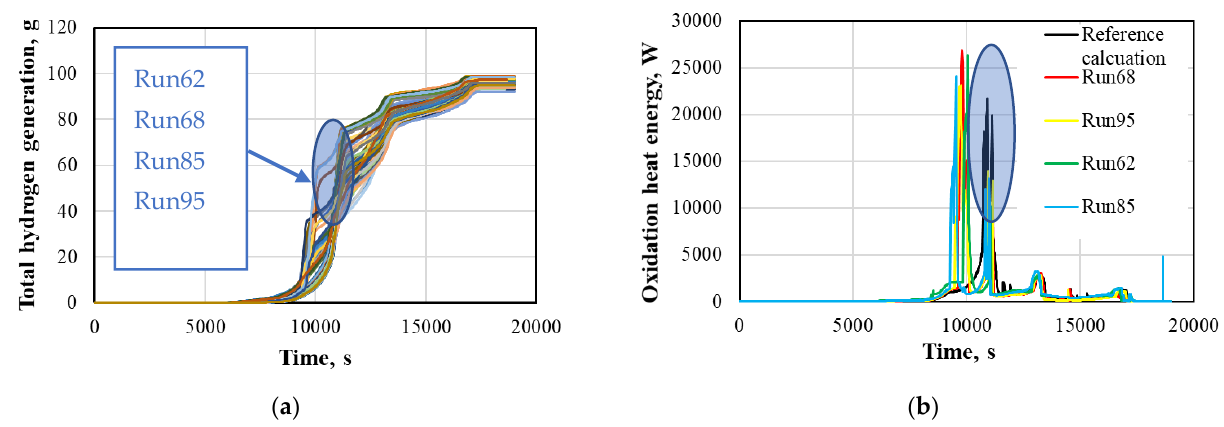
Figure 10. Calculation results: ( a ) 100 calculation results of total hydrogen generation, ( b ) oxidation heat energy for runs 68, 95, 62, and 85 compared with the reference case.